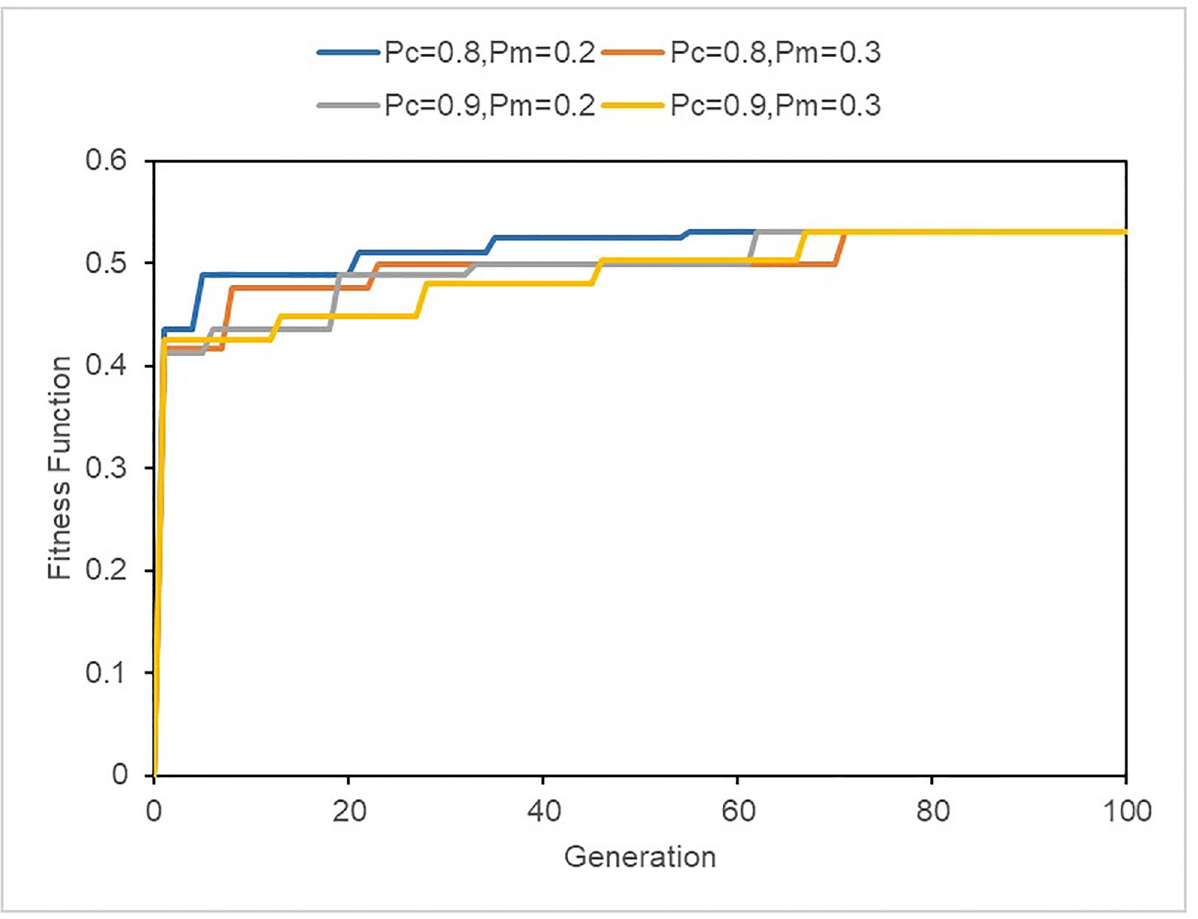
Fig 8. Convergence of the GA under different